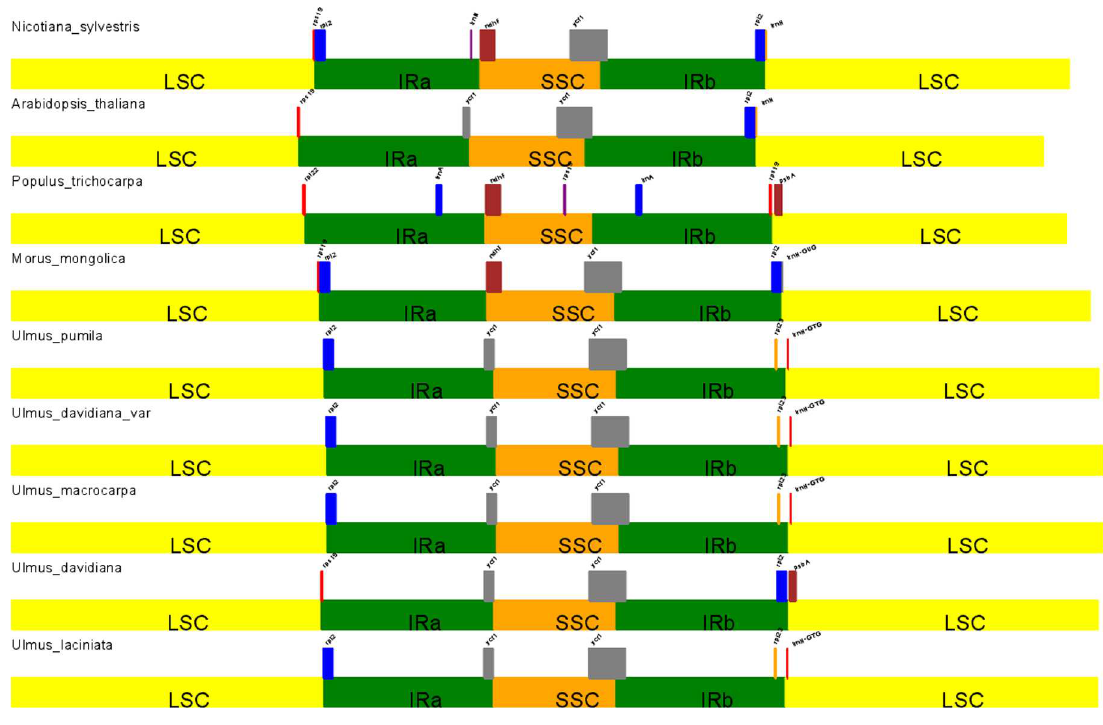
Fig 8. IR contraction analysis of various plant